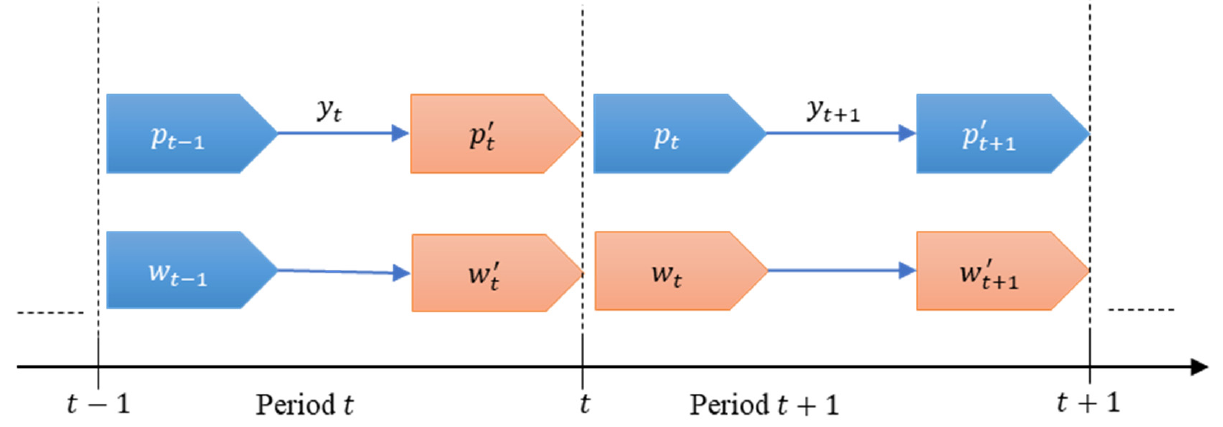
Figure 2. Portfolio value and weight vector evolution.